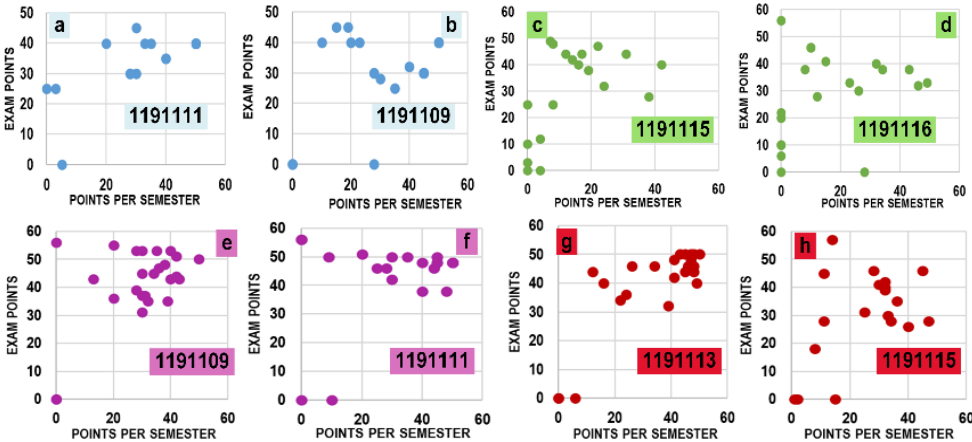
Figure 9. Exam results in Maths (( a , b ) — teacher 1, ( c , d ) — teacher 2) and in Structural Materials Technology ( e , f ) — teacher 3, ( g , h ) — teacher 4).